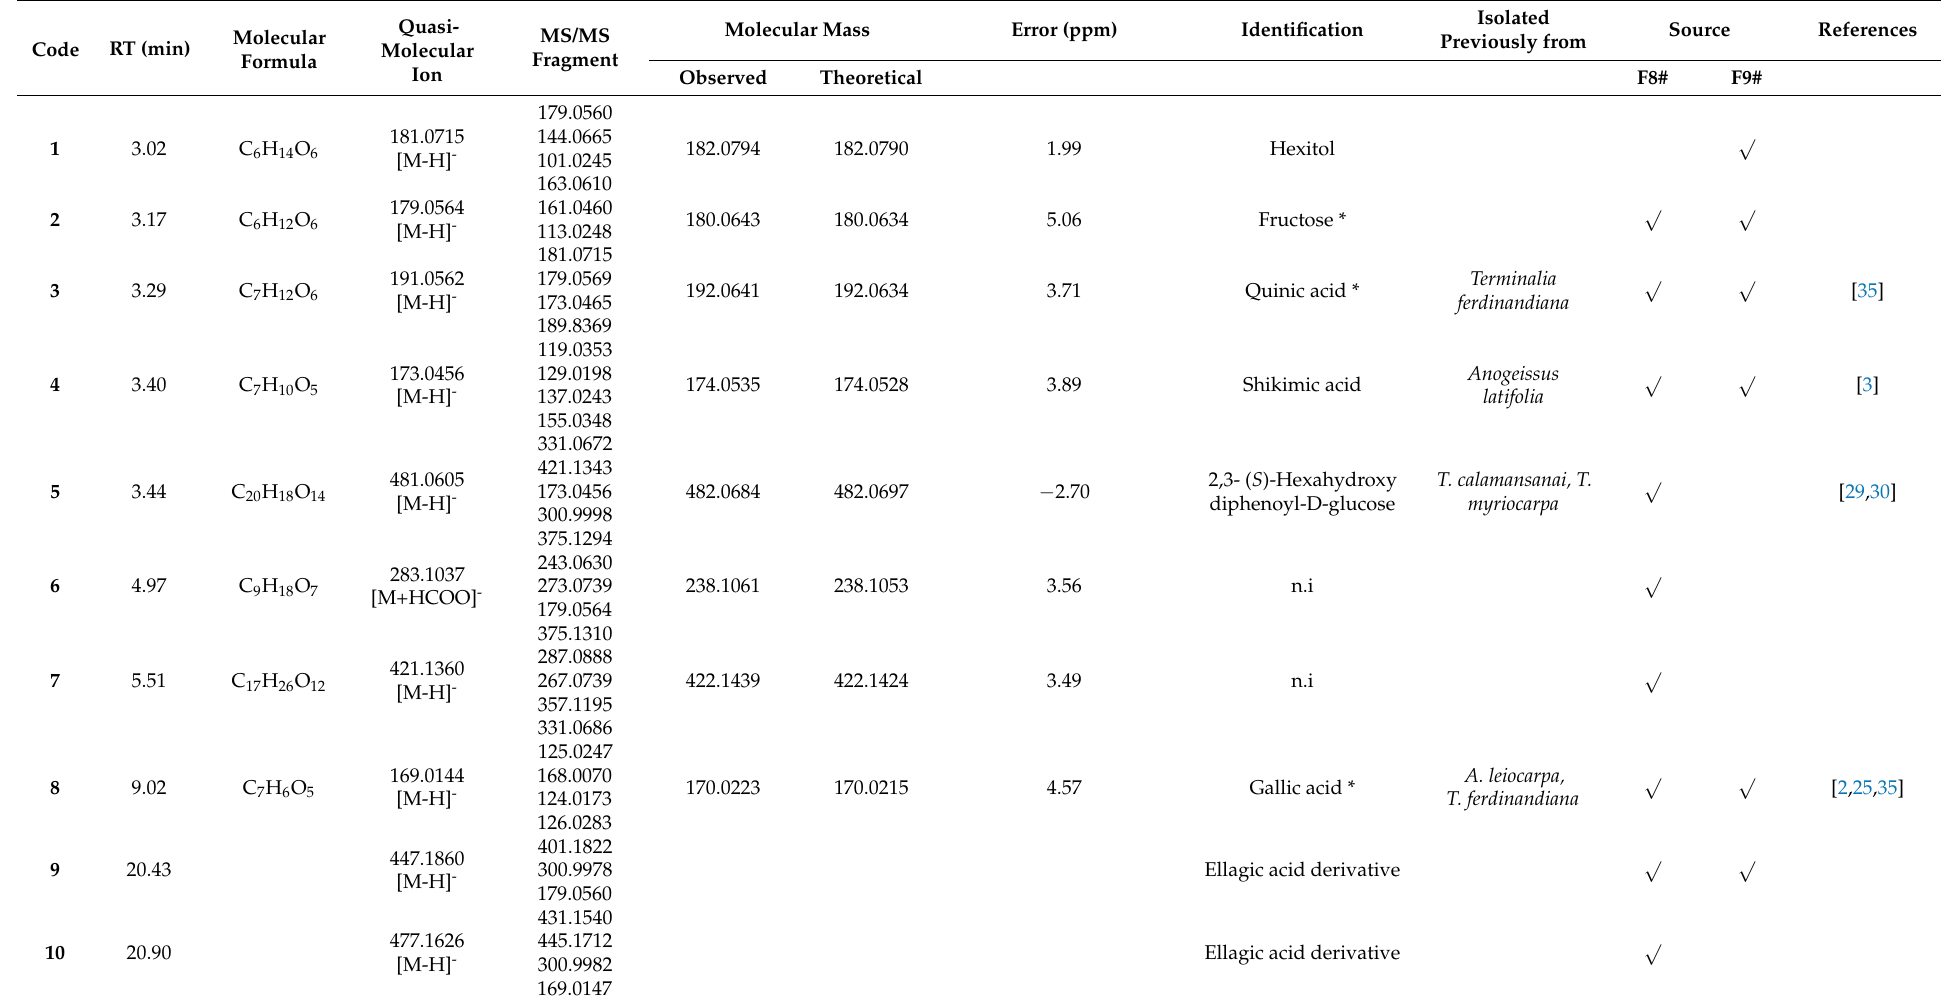
Table 2. HPLC-DAD-HRMS/MS data (APCI negative mode) of the major compounds identified in fractions 8 and 9 of the MeOH extract of Terminalia leiocarpa